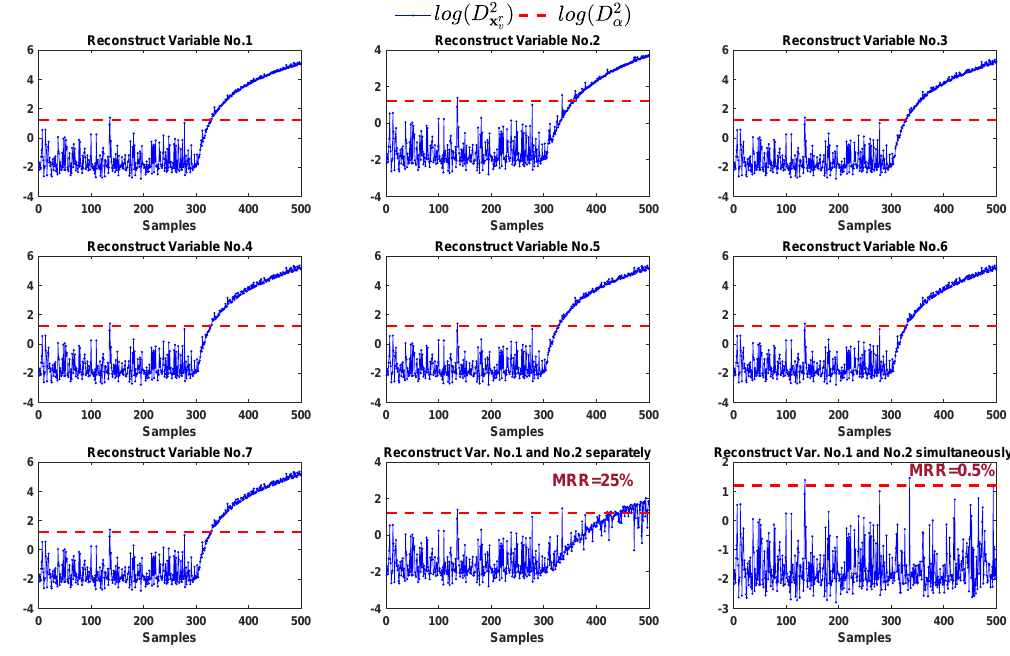
Figure 10. The fault detection results by eliminating faulty variable for case 3.